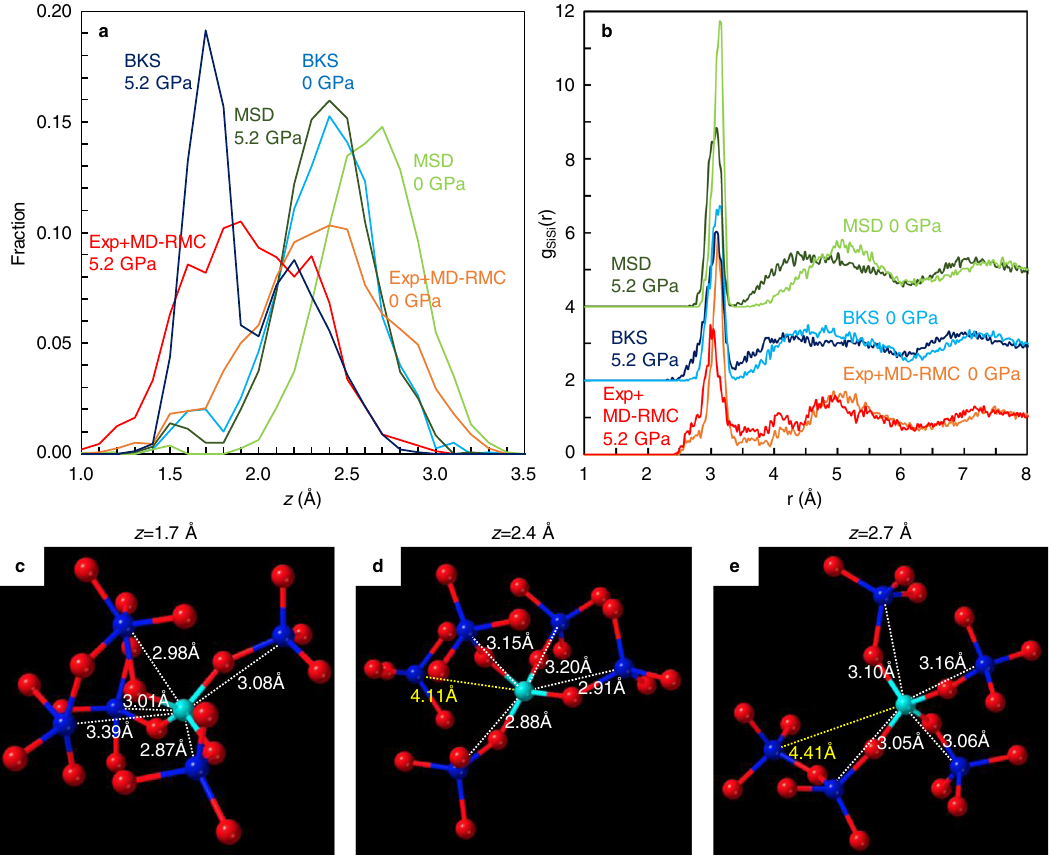
Fig. 5 Structural features of SiO 2 glass under pressure. a Translational order in SiO 2 glass as a function of the parameter z obtained in our experiment with MD-RMC modeling (Exp + MD-RMC) and MD simulations with BKS and MSD models at 0 and 5.2 GPa. Source data are provided as a Source Data fi le. b Partial pair distribution functions of Si-Si [g + 2 and + 4, SiSi (r)]. The g SiSi (r) of the BKS and MSD models are displayed by a vertical offset of respectively. c – e Structural features of SiO 2 glass with the characteristic distribution of z = 1.7 Å in the BKS model at 5.2 GPa ( c ), z = 2.4 Å in the BKS model at 0 GPa ( d ), and z = 2.7 Å in the MSD model at 0 GPa ( e ). Blue and light blue spheres represent silicon atoms and red spheres represent oxygen atoms. Numbers represent distances to the nearest fi ve silicon atoms (blue spheres) from a silicon atom shown by light with a diameter of 2.5 mm and height of ~1.5 mm was placed into the MgO ring with a BN cap. Pressures were determined by the equation of the state of MgO 27 . Densities of SiO 2 glass at high-pressure conditions were calculated from experi- mentally measured density up to 8.6GPa 28,29 .